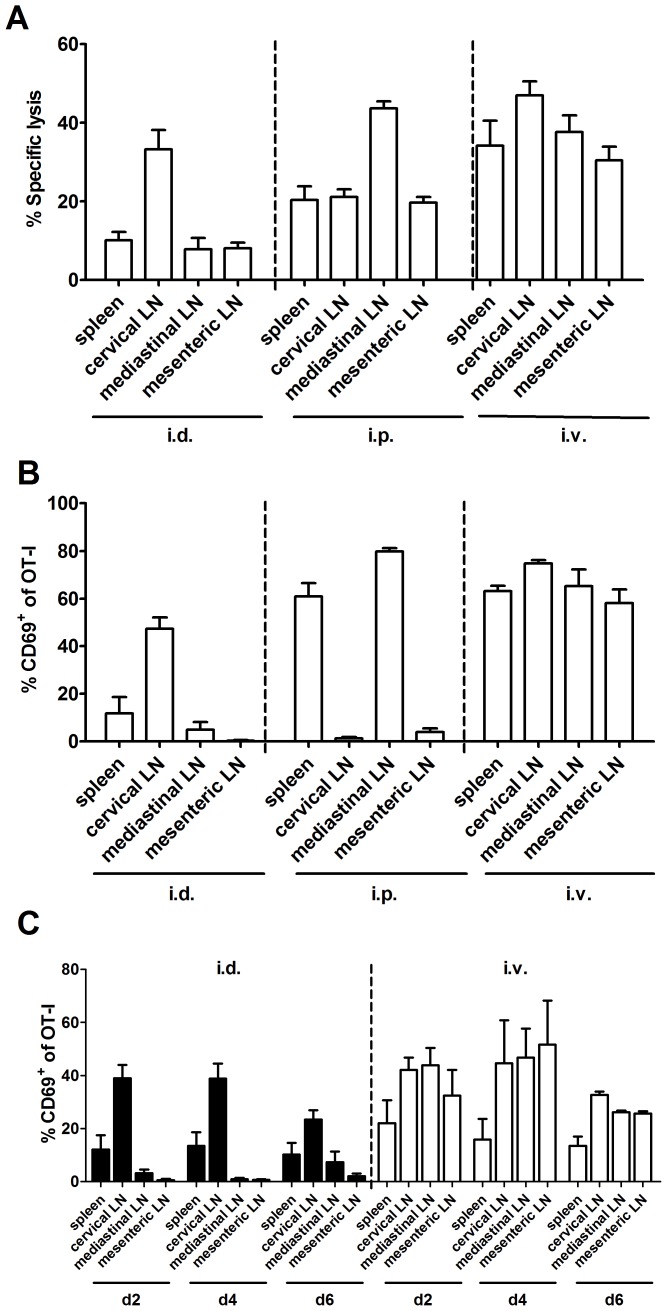
Wider spread but not longevity of antigen presentation is associated with systemic routes.A) Cytotoxicity in lymphoid organs of mice infected with 1×106 PFU of VACV WR by the routes shown was determined by measuring the specific lysis of B820 epitope–pulsed splenocytes two days after infection. Data are from two or more experiments and total mice for each route were: i.d. 7, i.p. 9 and i.v. 7. Killing in the spleen was significantly lower for i.d. compared with i.p. (p<0.05) or i.v. (p<0.01) infected mice. B) B6.SJL mice were given 5×106 OT-I CD8+ T cells (CD45.2+), then the following day infected with 1×106 PFU of VACV NP-S-GFP by the routes shown. At 24 hours post-infection, expression of CD8, CD45.2 and CD69 were measured by flow cytometry on cells from spleens and LNs. Mean and SEM of percent of OT-I CD8+ cells expressing CD69 is shown. Data are from two or more experiments and total mice for each route were: i.d. 5, i.p. 5 and i.v. 3. Priming of OT-I in the spleen was significantly (p<0.05) lower for i.d. compared with i.p. (p<0.01) or i.v. (p<0.001) infected mice. C) B6.SJL mice were infected with 1×106 PFU of VACV NP-S-GFP by the routes shown then given 5 × 106 OT-I CD8+ T cells (CD45.2+) 1, 3 and 5 days later. Expression of CD8, CD45.2 and CD69 were measured by flow cytometry on cells from spleens and LNs 24 hours after transfer to give times 2, 4 and 6 as shown on the graph. Means and SEM of percent of OT-I CD8+ cells expressing CD69 are shown.